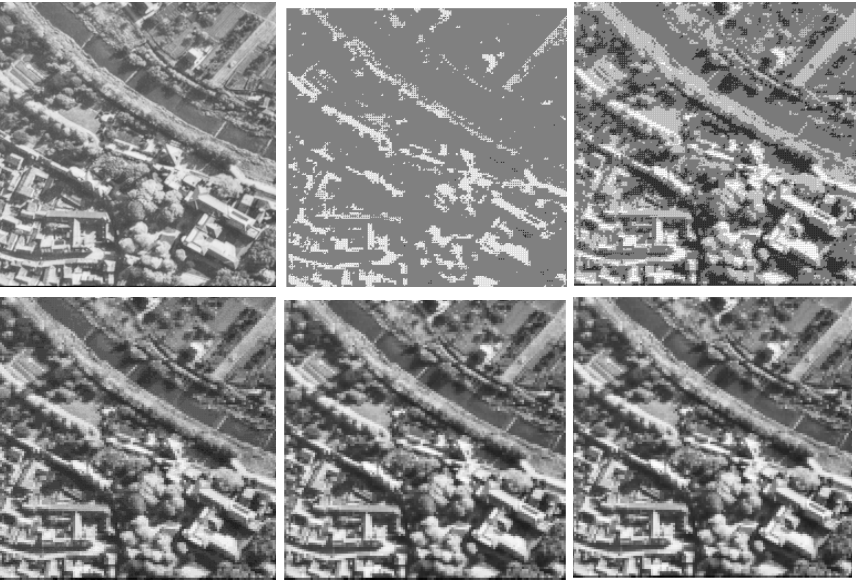
Figure 3: Top left corner: orinal image; left to right: reconstructed Aerial image using 2 × 2 blocks at quality indices 5 , 10 , 50 , 90 , 95